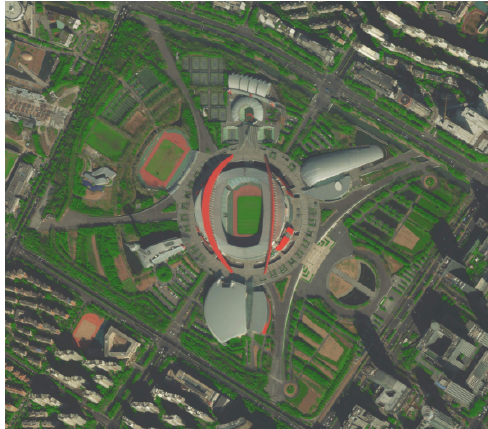
Figure 4. Top view of Nanjing Olympic Sports Center.